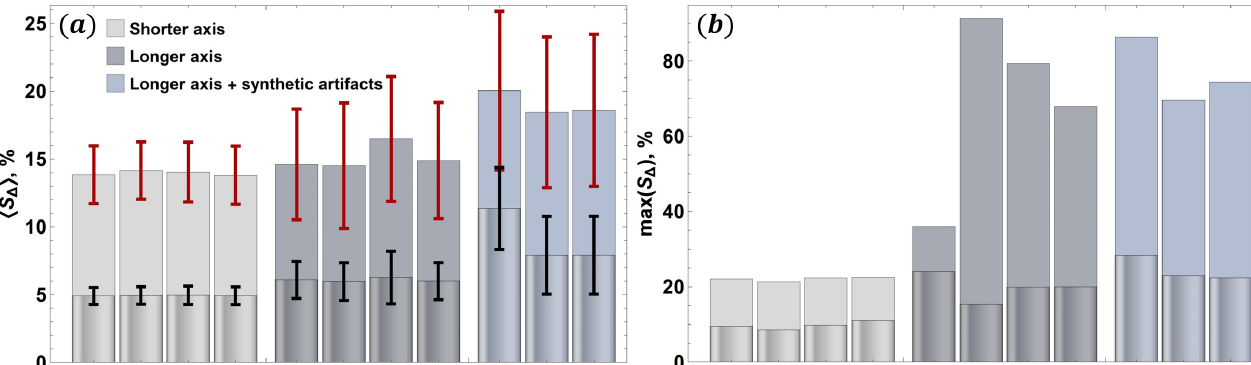
Figure 29. Smooth normalized δ x ( a , c , e ) and δ y ( b , d , f ) histograms for the cases with the moving body: neutron flux transmission along the ( a , b ) smaller axis, ( c , d ) larger axis and ( e , f ) the latter with the addition of synthetic image artefacts.